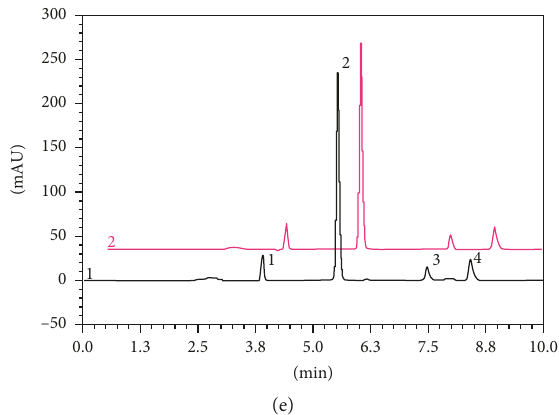
Figure 3: Chromatograms obtained during specificity study. (a)–(e) Drug product (20 µ g oxidative degradation (30% H 2 O 2 ); (c) basic hydrolysis (1.0 mol/L NaOH) at 80 ° C; (d) acid hydrolysis (1.0 mol/L HCl) at 80 ° C; (e) dry heat at 60 ° C. Impurity 1 (peak 1; 3.91 min); LGT (peak 2; 5.52min); impurity 2 (peak 3; 7.47min); impurity 3 (peak 4; 8.42min).